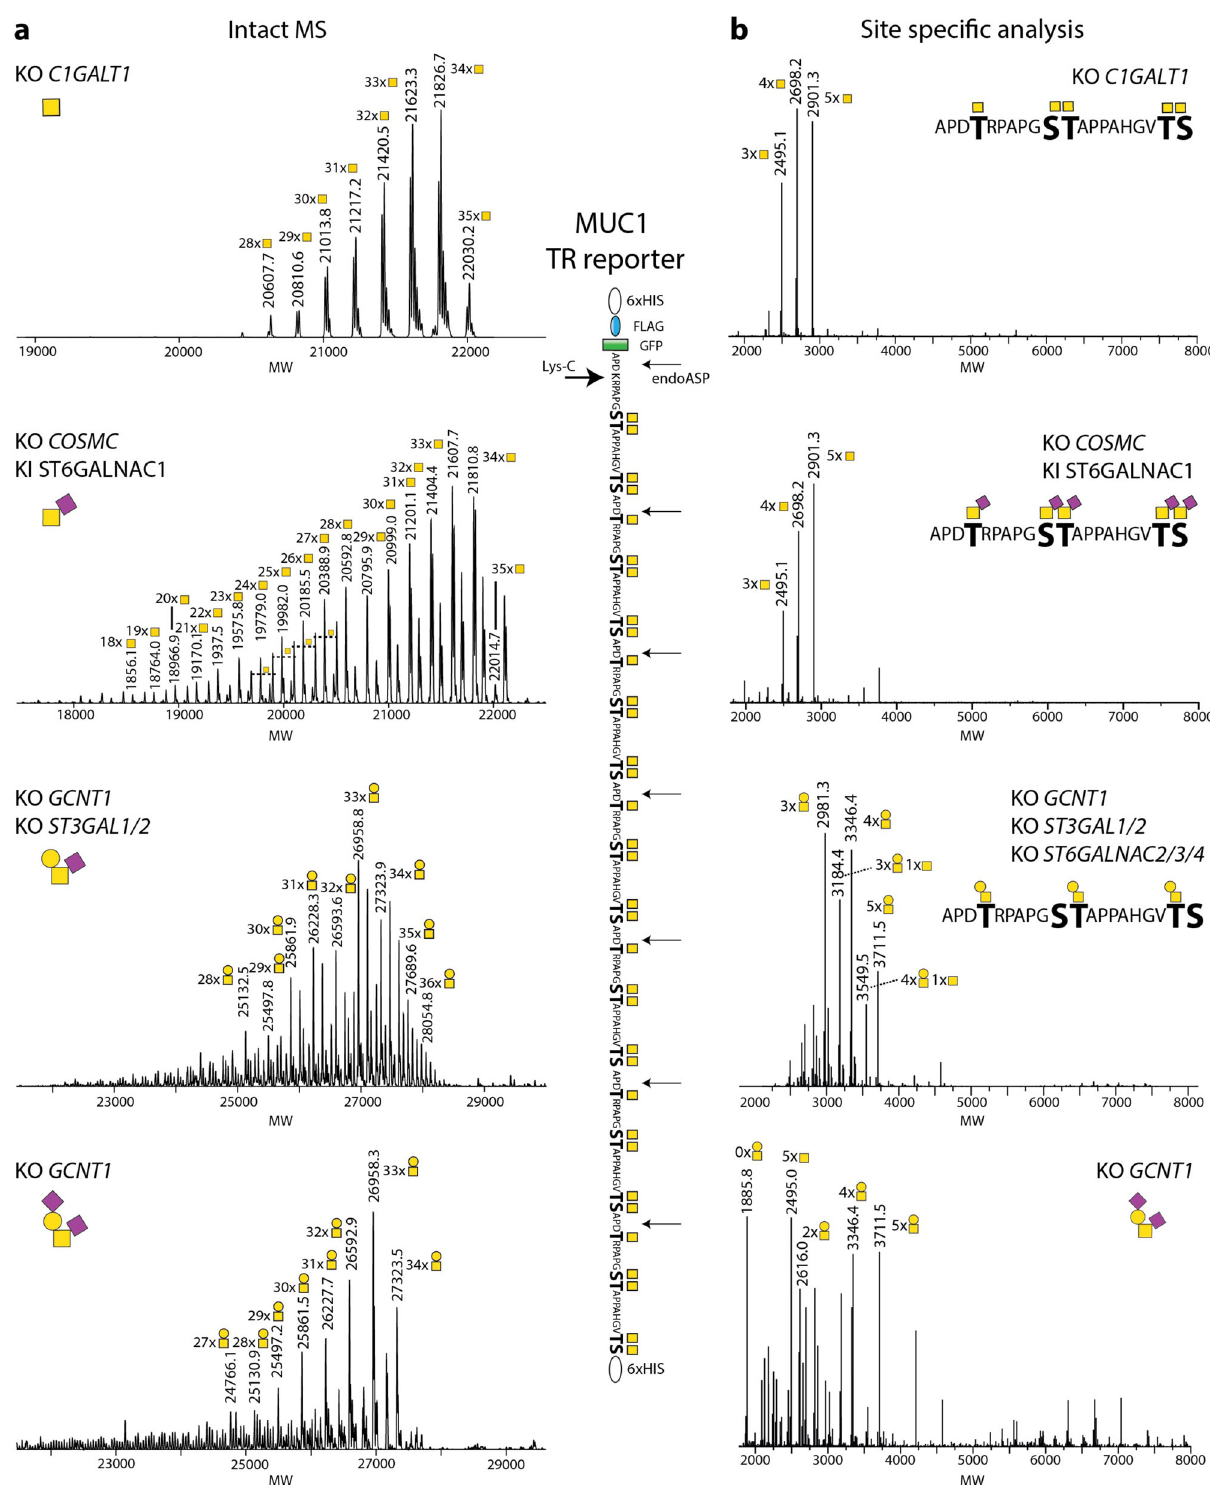
Fig. 2 Mass spectrometry analysis of secreted MUC1 TR reporter O-glycoforms. a Deconvoluted intact mass spectra of secreted, puri fi ed MUC1 reporter produced in HEK293 KO C1GALT1 , HEK293 KO COSMC, KI ST6GALNAC1 , HEK293 KO GCNT1, ST3GAL1/2 , and HEK293 KO GCNT1 cells. Reporters were treated with neuraminidase to remove sialic acids and reduce complexity, and digested by Lys-C followed by HPLC C4 isolation yielding the 157 amino acid MUC1 TR O- glycodomain fragment. All MUC1 O-glycoforms (Tn and T) showed a rather homogeneous mass comprising 32 – 35 HexNAc/HexHexNAc residues, and with 33 or 34 HexNAc/HexHexNAc being the most abundant peak. For all intact mass spectra experimentally determined and theoretically calculated masses were composed in Supplementary Table 4. b Site-speci fi c O-glycopeptide LC – MS/MS analysis of MUC1 reporters after AspN digestion.